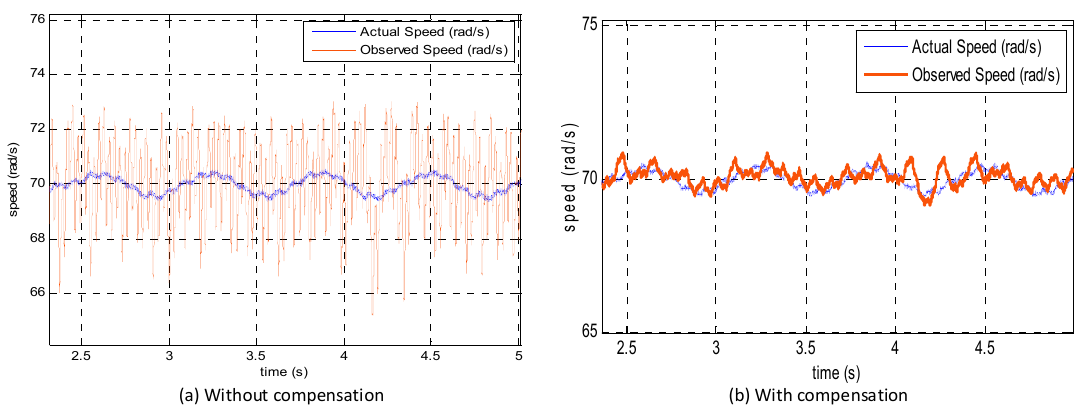
Figure 14. The experimental results of actual speed and observer speed at 70 rad/s.